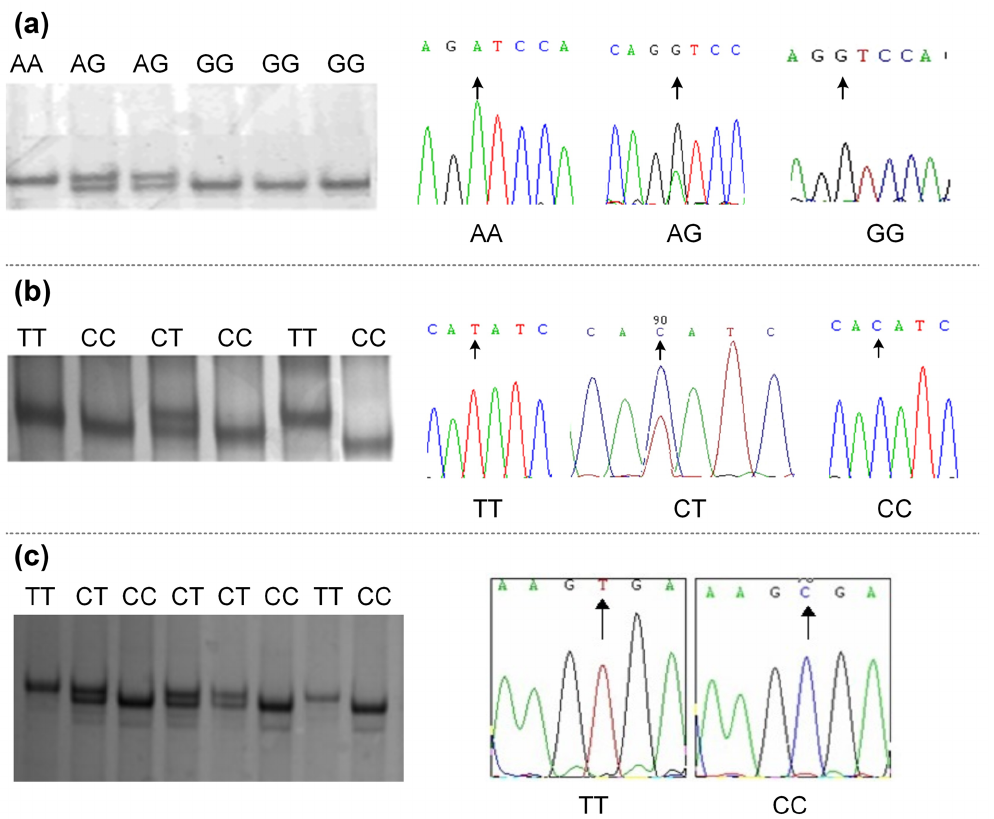
Figure 1. SNP identification and genotyping in bovine CAPN1 and CAST genes by the PCR-SSCP method. (a–c) Electrophoresis patterns and sequencing results of CAPN1 4558 A>G, CAPN1 4684 C>T, and CAST 596 T>C, respectively. Table 2. Genotype, allele frequencies, and genetic diversity parameters of bovine CAPN1 and CAST in four Chinese cattle populations.